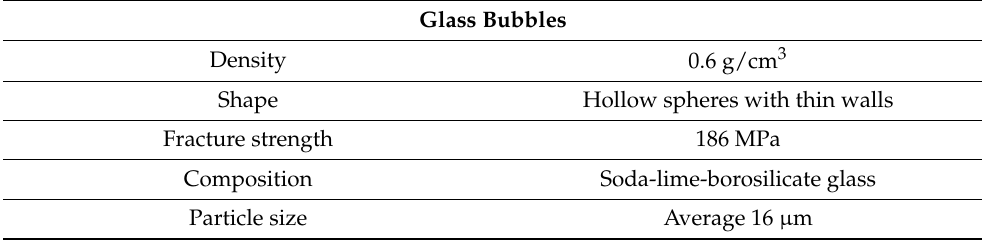
Table 1. Physical properties of glass